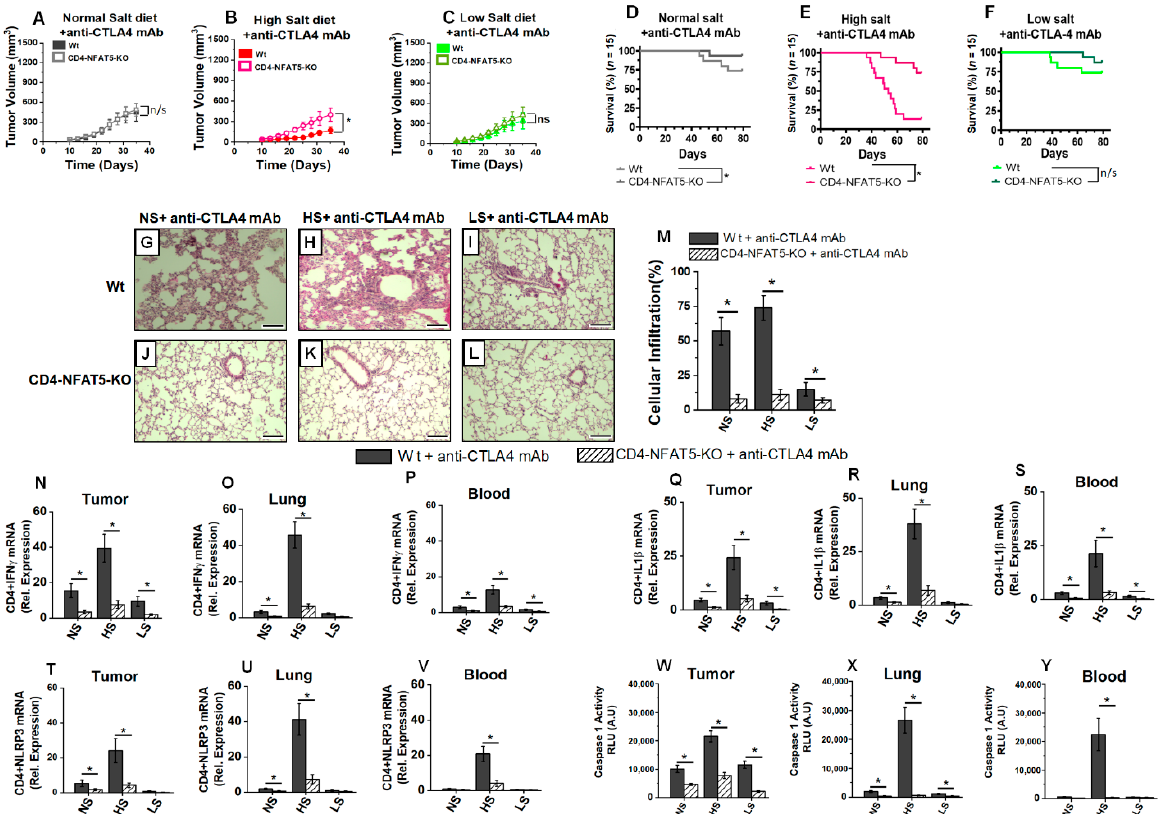
Figure 7. NFAT5 knock out reduces high-salt-mediated inflammatory activation of CD4+T cells and systemic inflammatory response in breast-tumor-bearing mice. ( A – C ) Tumor progression kinetics in NS ( A ), HS ( B ) and LS ( C ) cohorts in wild-type (Wt) and CD4-NFAT5-KO transgenic mice injected with syngeneic Py230 following treatment with anti-CTLA4 mAb. Data presented as mean ± SEM, n = 8, statistical analysis was performed using multiple t -test, (*) p -value < 0.05, n/s = not